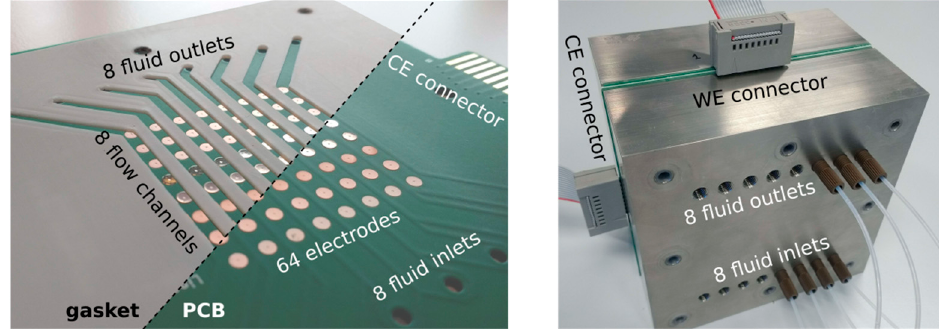
Figure 2. Left : Illustration of one PCB with 64 electrodes, showing part of a PTFE gasket visualizing fluid inlets and outlets, flow channels, and electric connector. Right : Partly assembled HT setup stack showing WE and CE connectors, and fluidic inlets and outlets which are repeated on the reverse side.